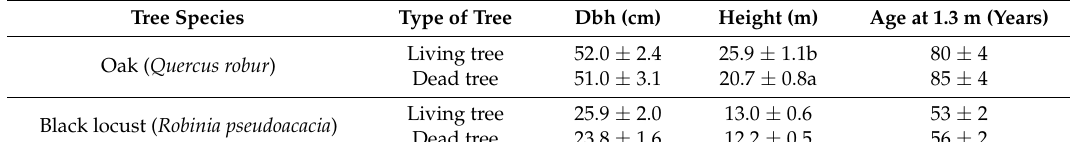
Table 1. Main features of the sampled living and dead trees. Values are means ± SE. Different letters indicate significant ( p < 0.05) differences based on t tests.